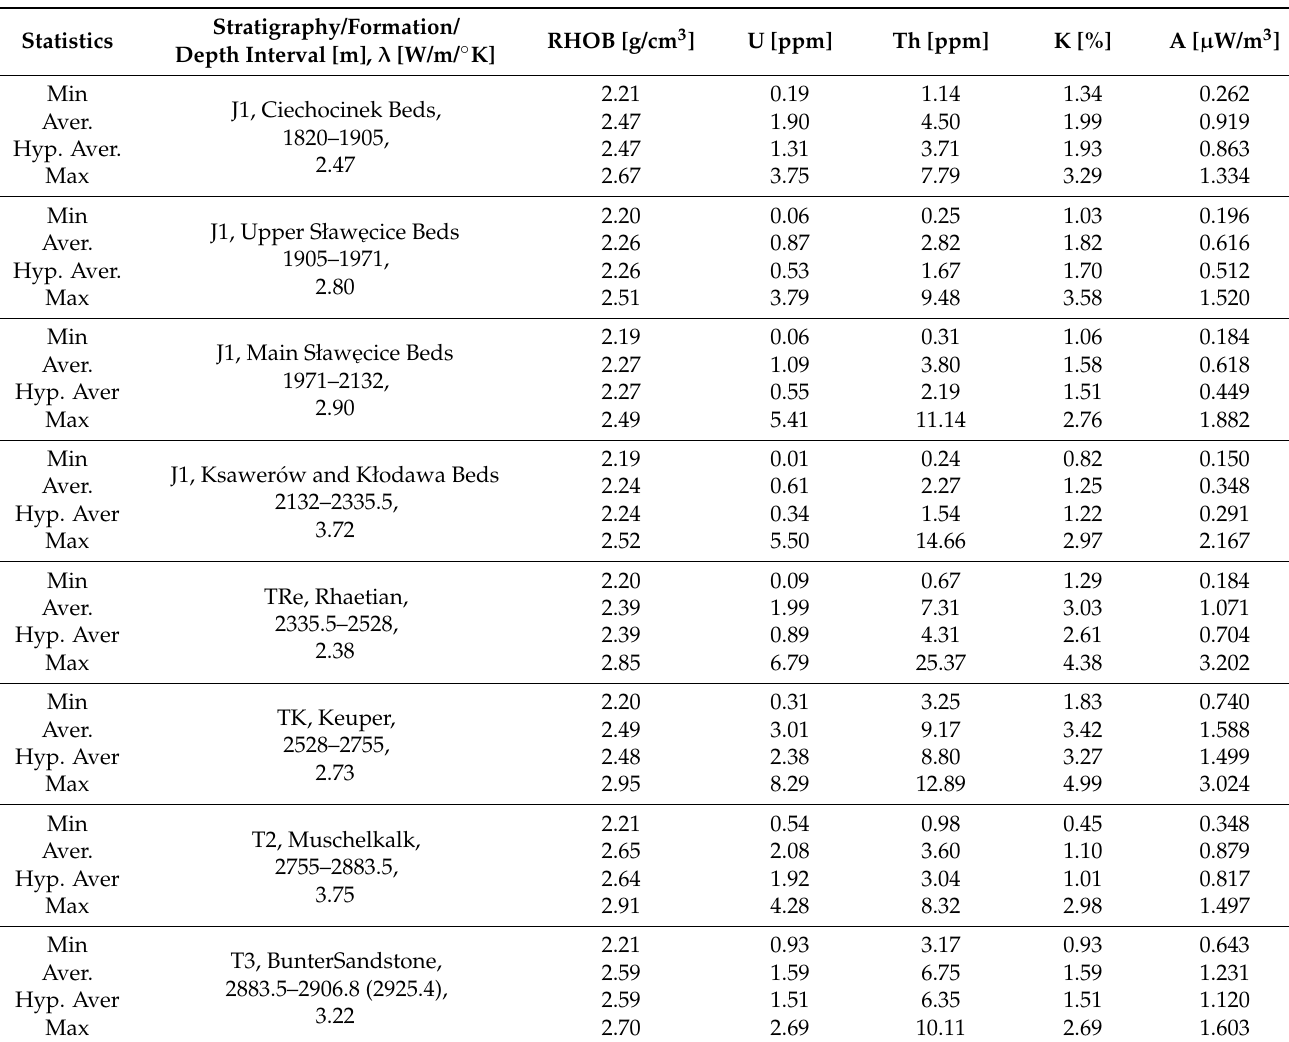
Table 4. Simple statistics of the bulk density, spectral gamma ray, spectral gamma-ray (SGR) data and radiogenic heat in the selected formations in GT-1 borehole (Central Polish Anticlinorium), stratigraphy and adopted thermal conductivity. Statistics